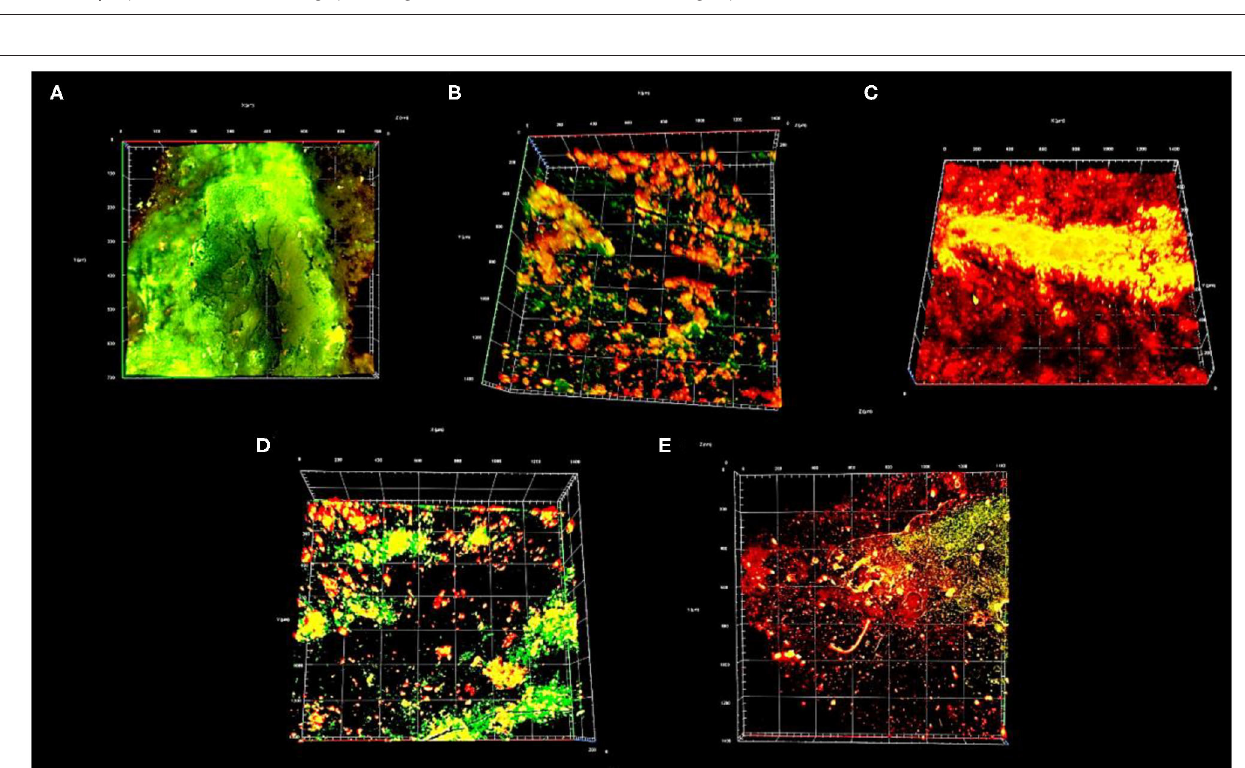
FIGURE 10 | Top view 3D image of confocal scanning microscope showing live (green) and dead (red or yellow) bacteria. (A) Untreated enamel caries like lesions (group I), (B) Desensibilize nano p (group II), (C) NHA-LPS suspension (group III), (D) NHA-SPS suspension (group IV), and (E) Sodium Fluoride (NaF) varnish (group V).